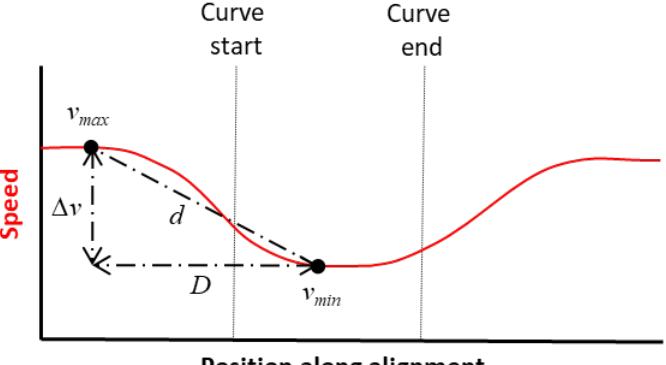
Figure 1. Overview of general approach and variables used in recent deceleration